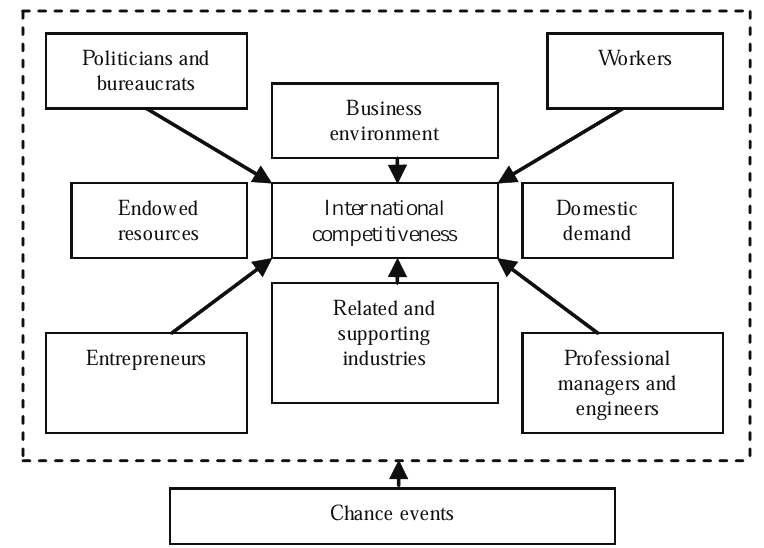
Fig. 3. The Nine-Factor model of international competitiveness (Cho